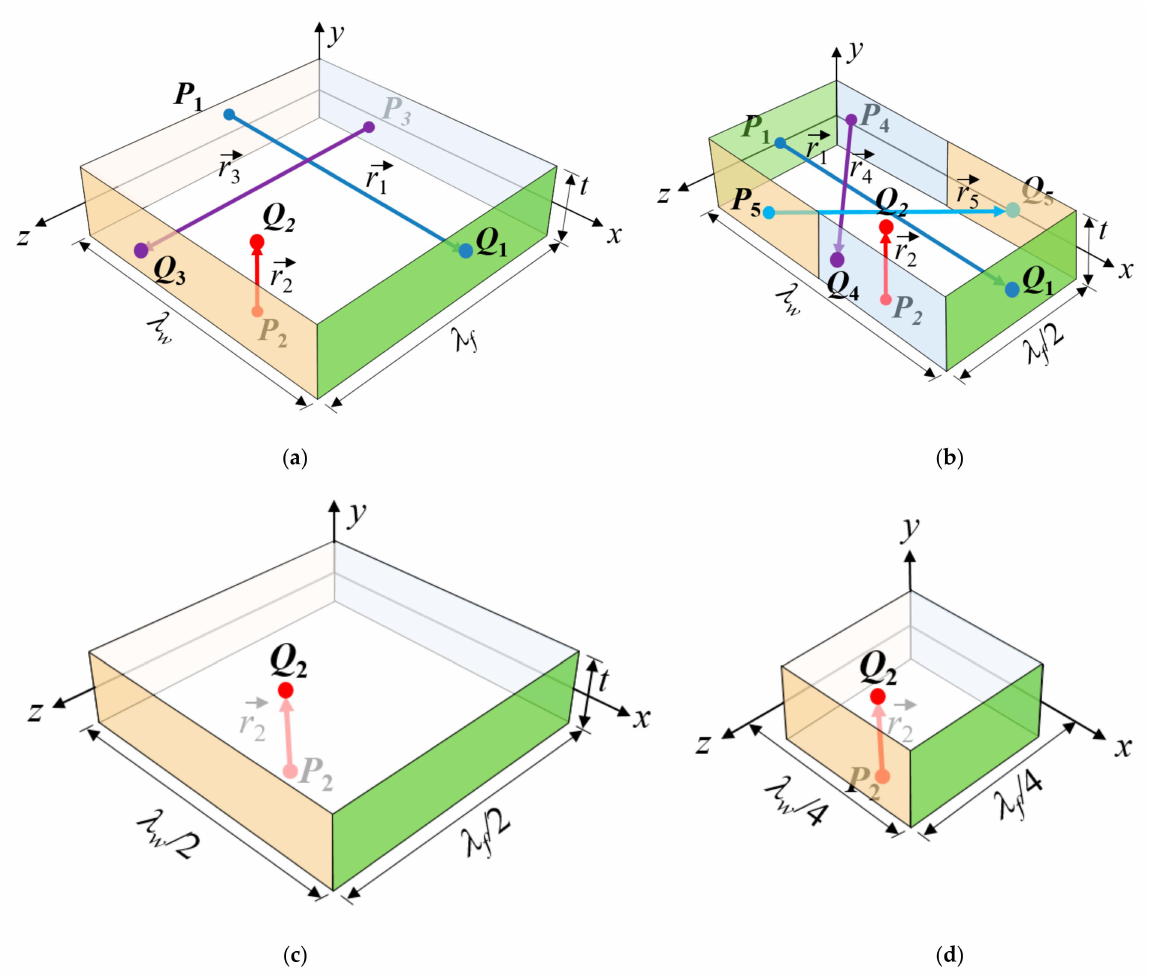
Figure 3. Periodicity vectors of full and partial unit cells: ( a ) full unit cell; ( b ) 1/2 unit cell; ( c ) 1/4 unit cell; and ( d ) 1/16 unit